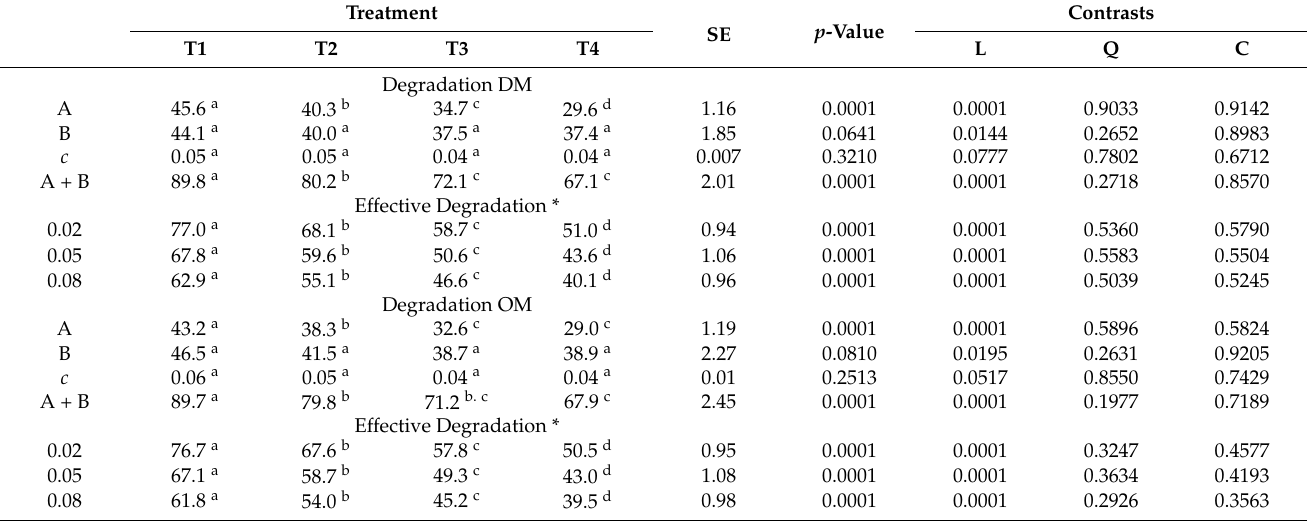
Table 2. In situ rumen degradation kinetics and in vitro digestibility (DM and OM) of diets with increasing levels of A. mearnsii (except where otherwise